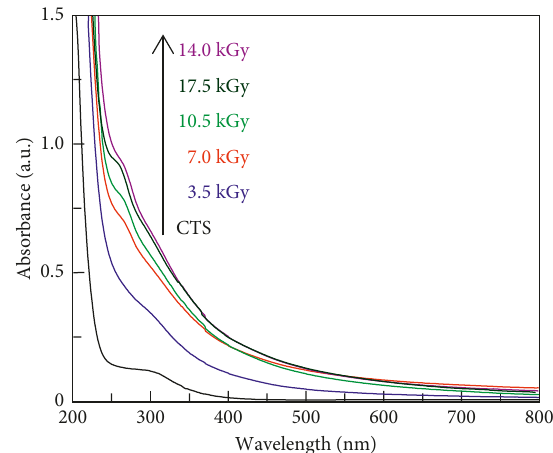
Figure 1: UV-Vis spectra of CTS and Pt 4+ /CTS solutions irradiated with different